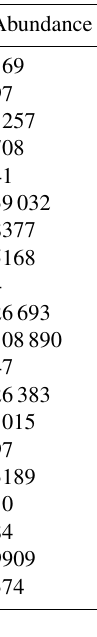
Table 1. Sample types and abundance in